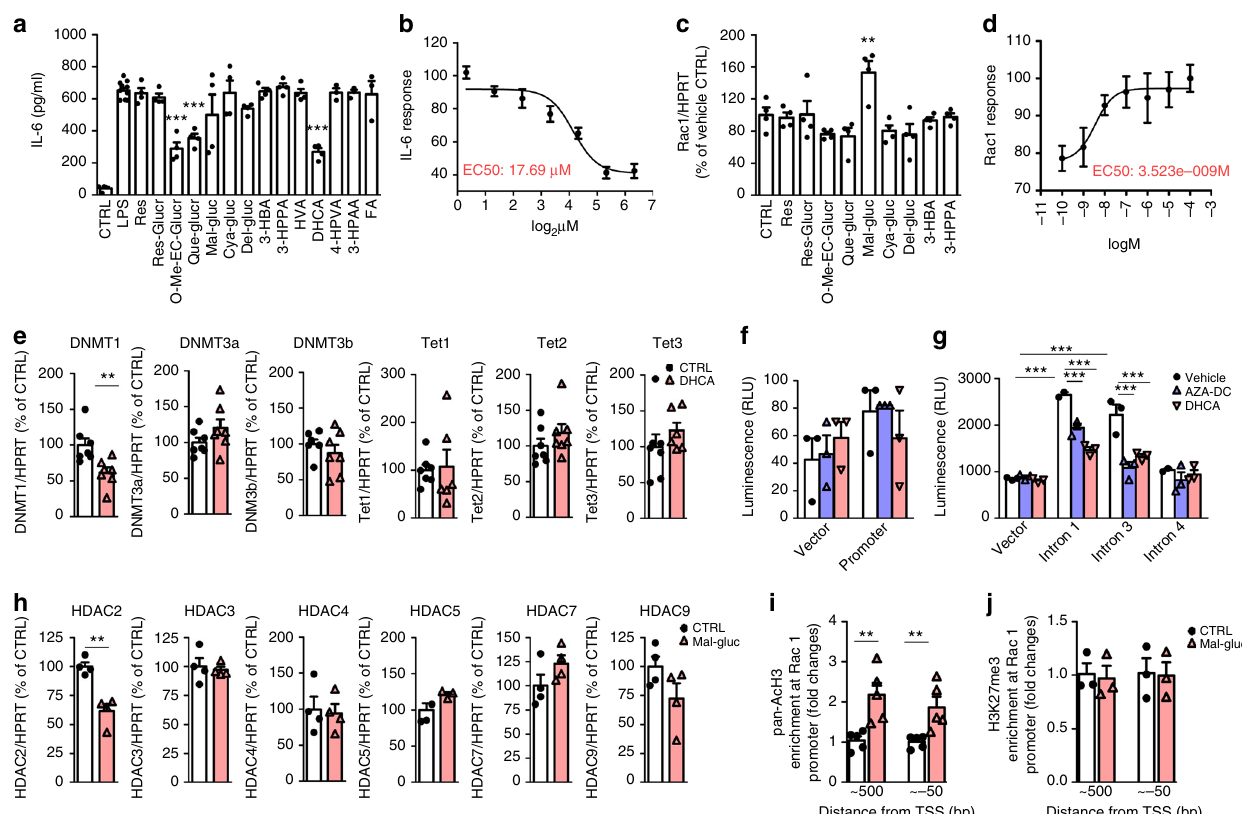
Fig. 2 In vitro screening of phenolic metabolites to modulate IL-6 and Rac1 and mechanistic investigation of the role of DHCA on IL-6 and Mal-gluc on Rac1. a , b Screening of the effect of plasma bioavailable phenolic metabolites in inhibition of IL-6 in PBMCs following LPS stimulation. a Primary screening of